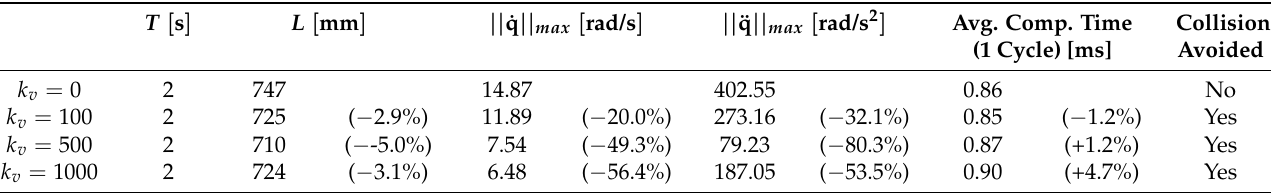
Table 3. Results from simulations of Example